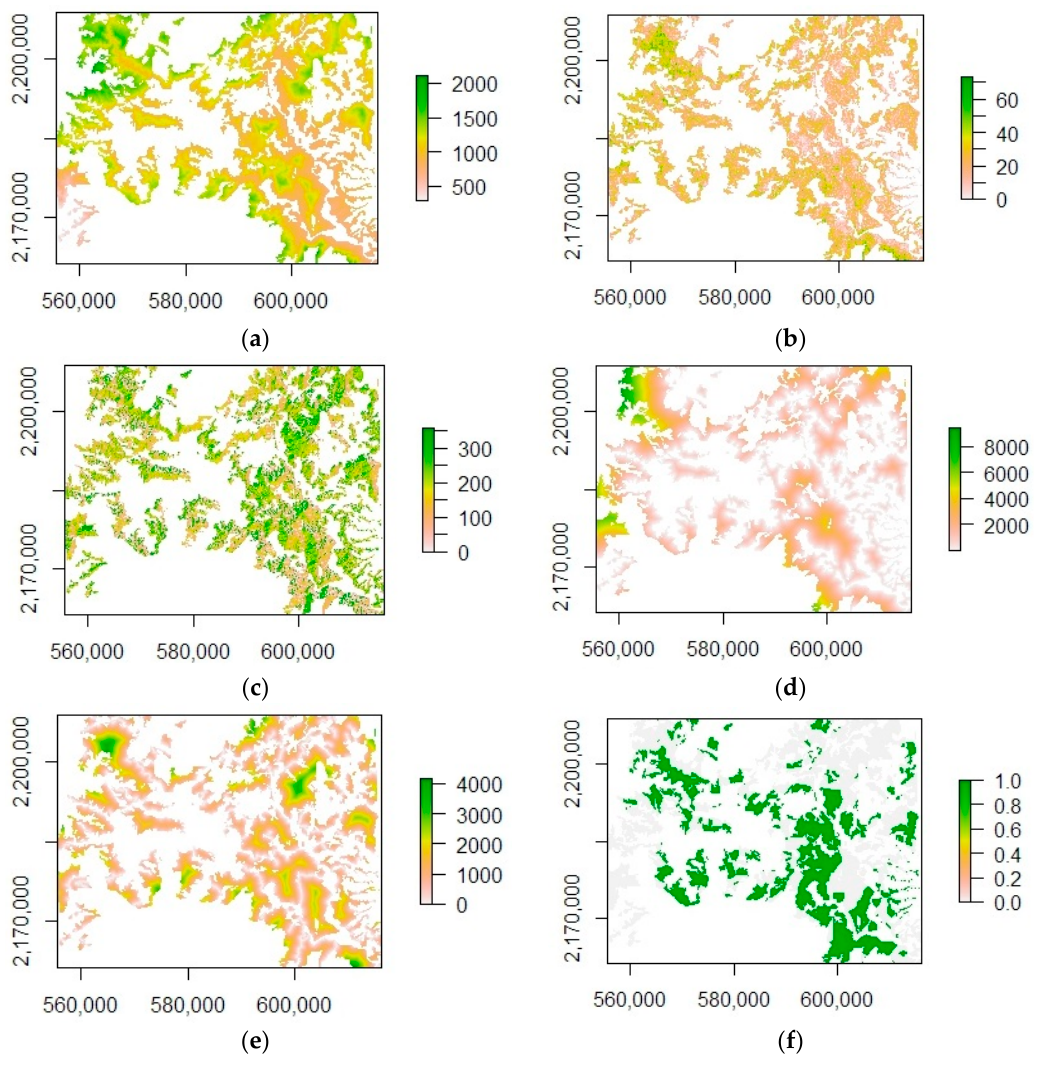
Figure 4. Explicative spatial variables: ( a ) elevation, ( b ) slope, ( c ) aspect, ( d ) distance to agriculture, ( e ) distance to roads, and ( f ) land ownership.